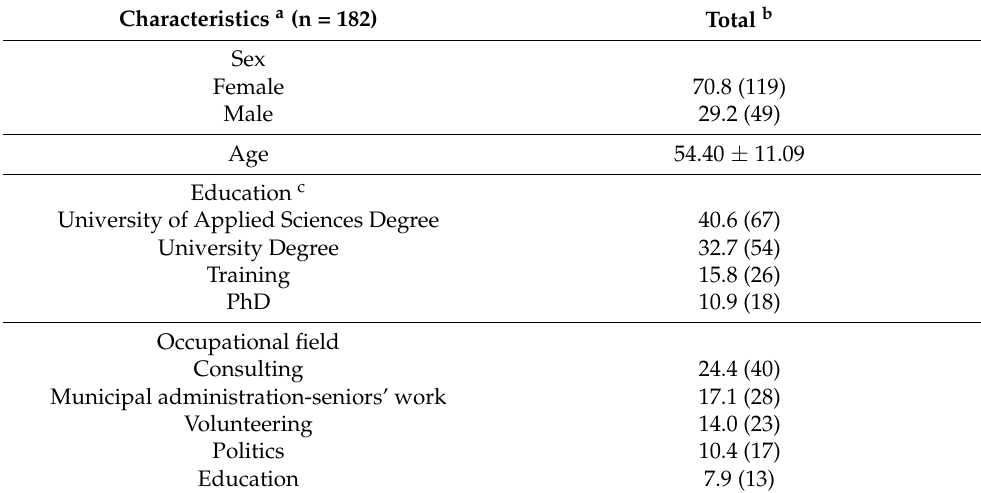
Table 2. Characteristics of